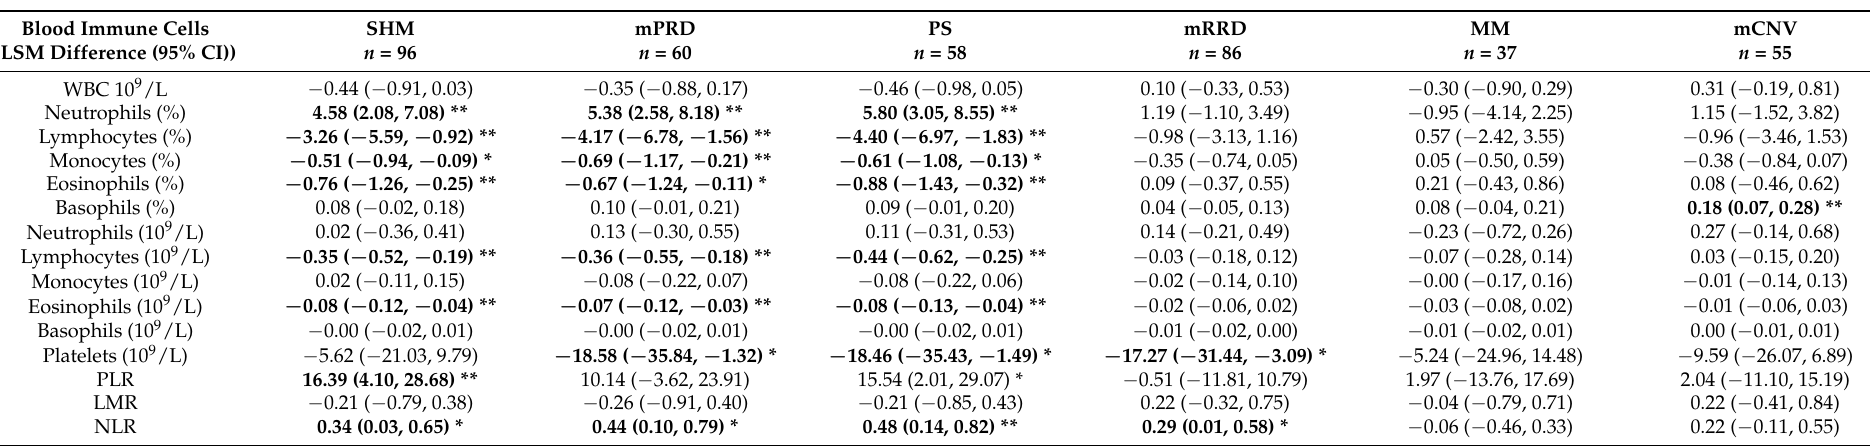
Table 4. Multivariable linear regression analysis of blood immune cells between emmetropic controls and the subgroups of myopic